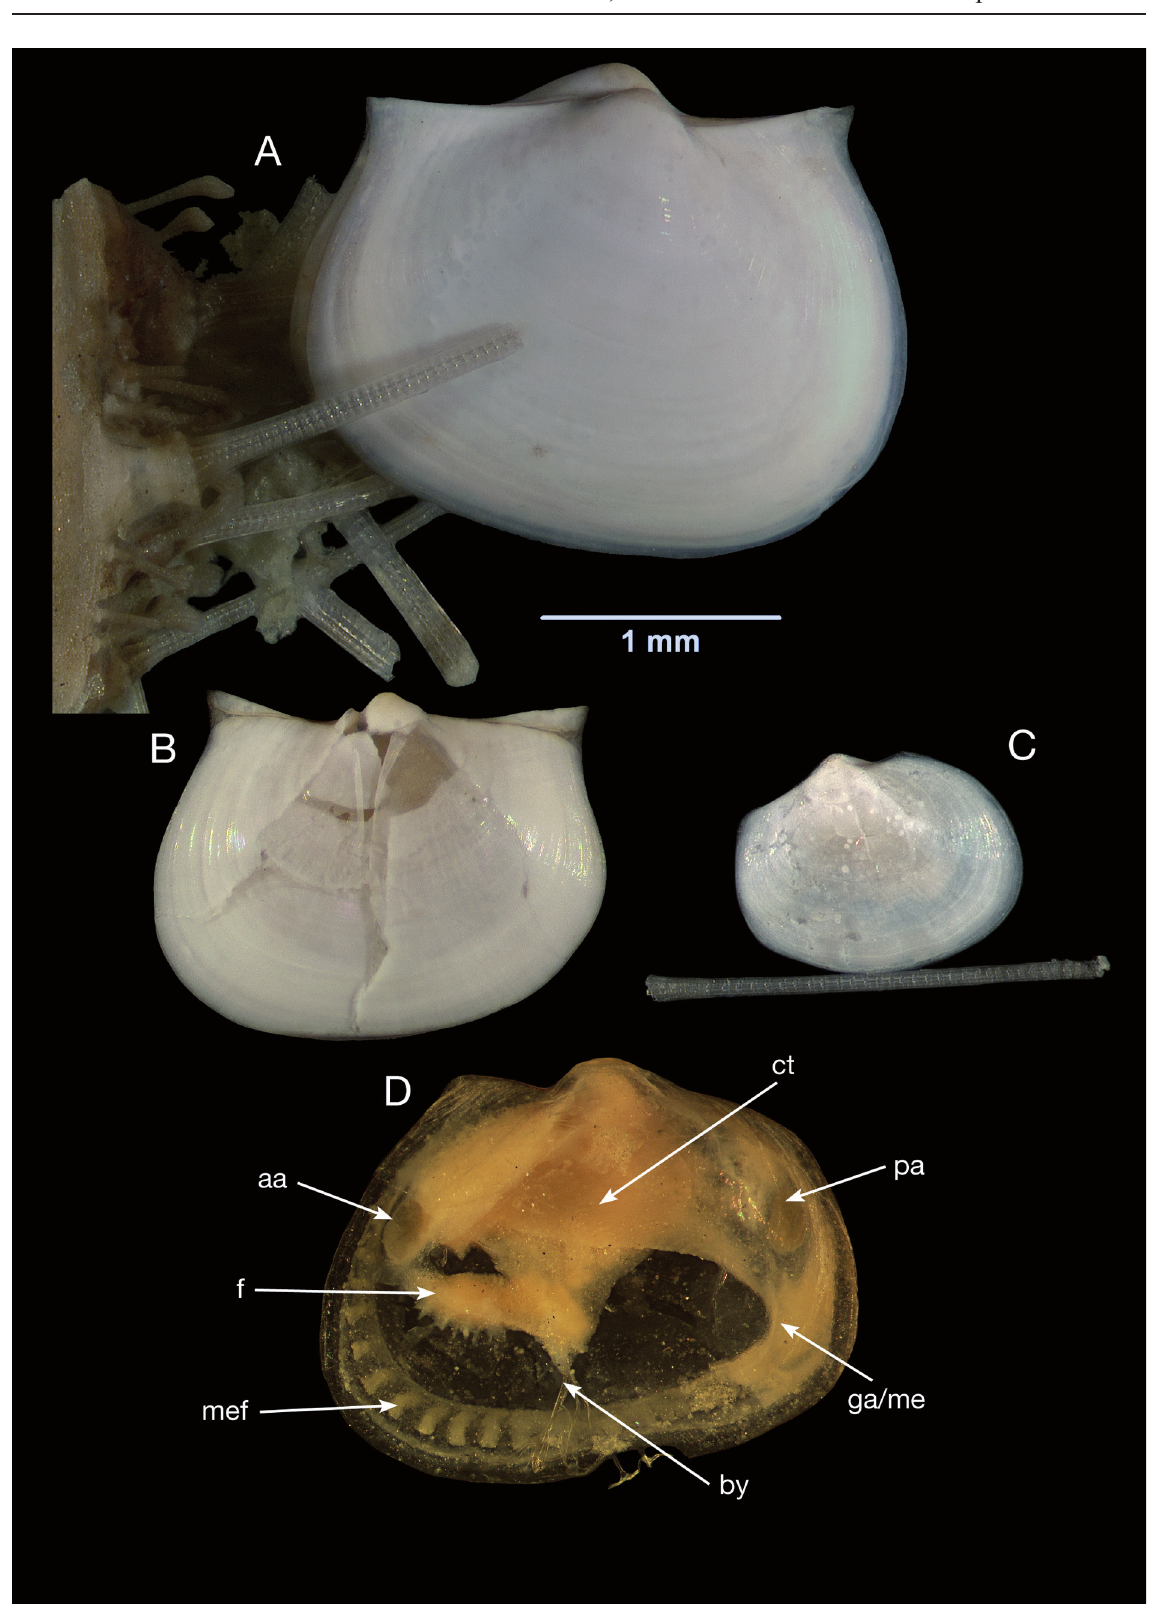
Fig. 10. Ptilomyax hadalis sp. nov. A . Holotype attached to echinoid spines. B . Paratype, left side. C . Juvenile paratype lacking “wings”. D . Anatomy of a paratype as viewed from the left